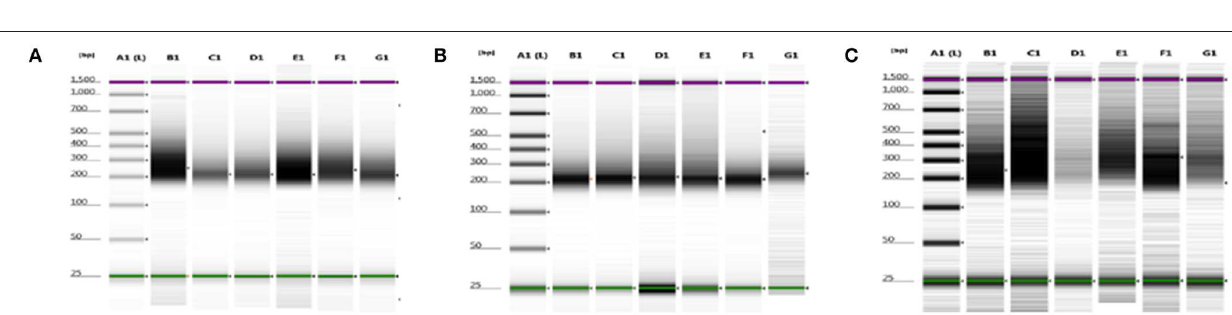
FIGURE 2 | cDNA quality check using gel electrophoresis after SMARTer protocol. (A–C) Gel images of 8749/2010, 2758/2012, and 6475/2007 samples, respectively. Purple and green lines are intrinsic upper and lower markers, respectively. (A–C) Three independent experiments. Lane A1, ladder; lanes B1–G1 sample compartments (B1, PTC; C1, TC; D1, PS; E1, NS; F1, TV; G1,